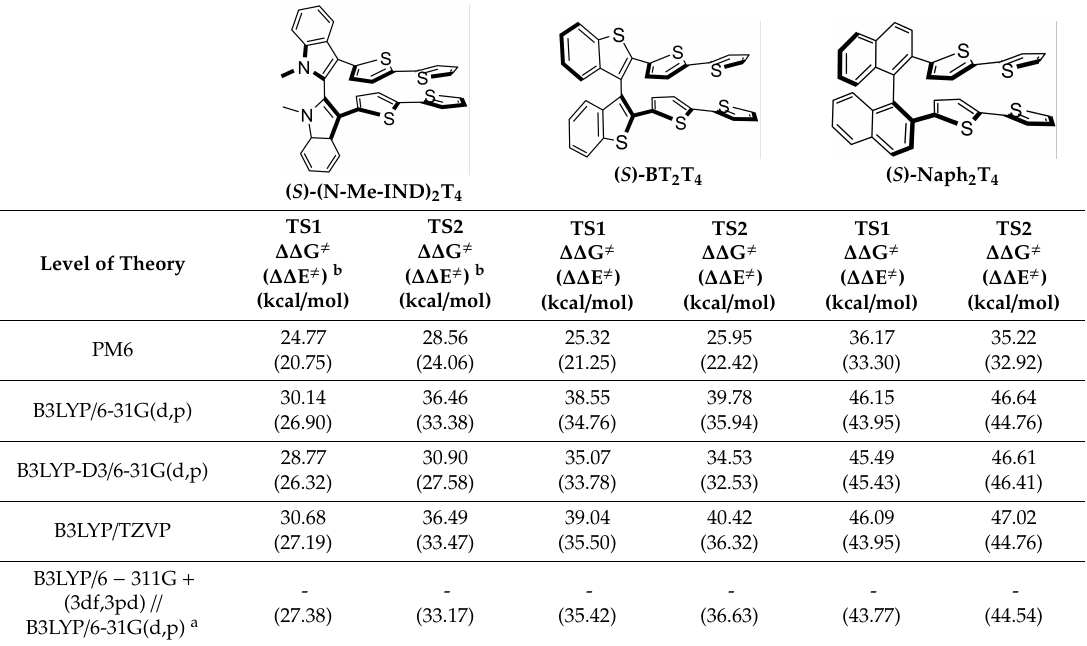
Table 1. A comparison of torsional energy barrier calculations for di ff erent atropisomeric sca ff olds, performed by di ff erent computational strategies. a Single point energy values. b Di ff erence between the energy of the TS and the energy of the fundamental